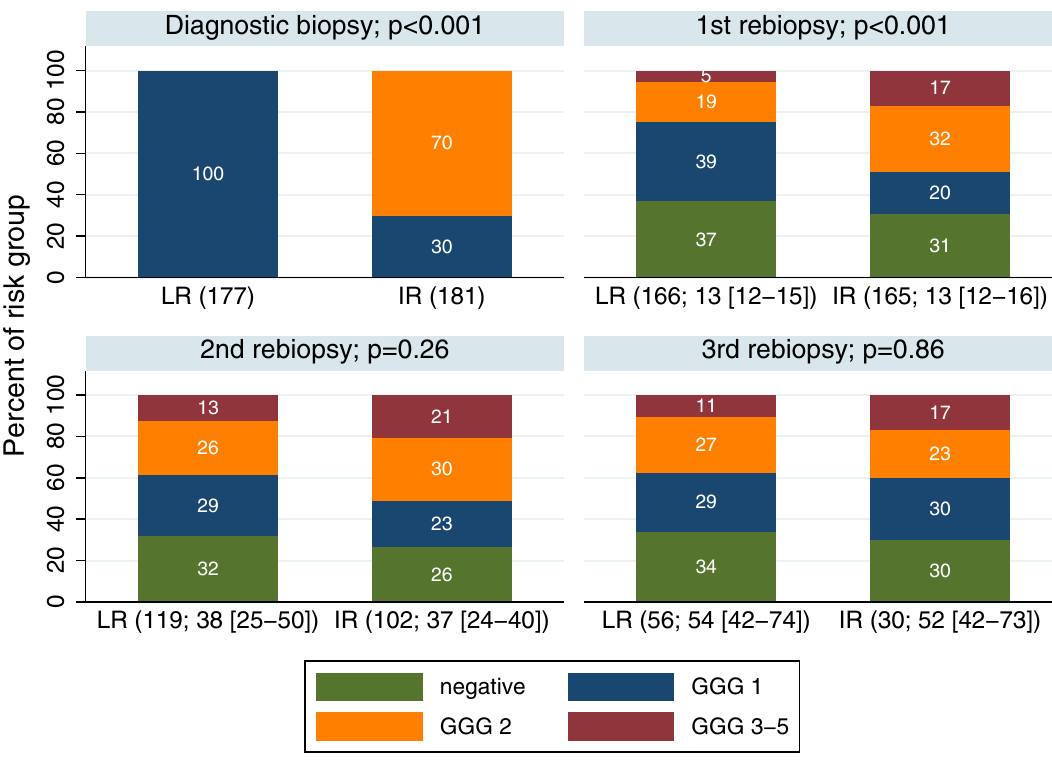
Figure 2. Changes in Gleason grade group with repeat biopsy over time. Number in parentheses represents number of patients and months from diagnosis to a biopsy procedure reported as median with interquartile ranges, respectively. GGG Gleason grade group, LR low-risk, IR